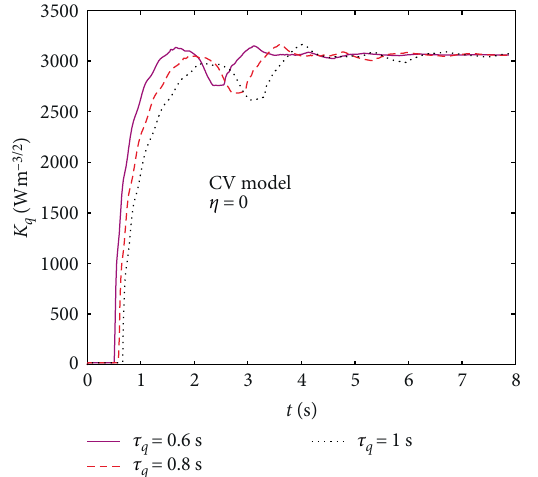
Figure 6: Effect of on HFIF for a homogeneous cylinder based 𝜏 𝑇 on the DPL model.